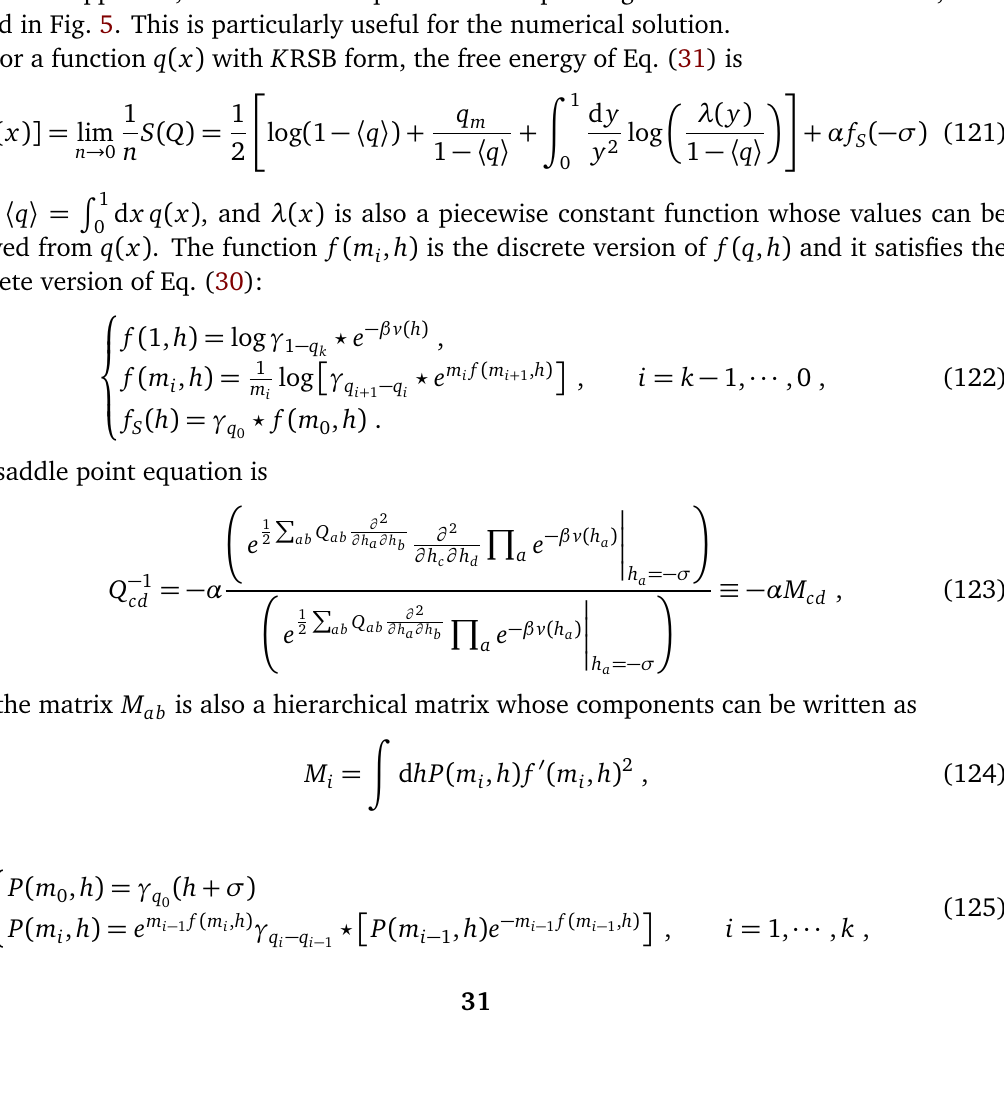
for a 4RSB case. The reader ab ≡ m , m ≡ k + 1 0